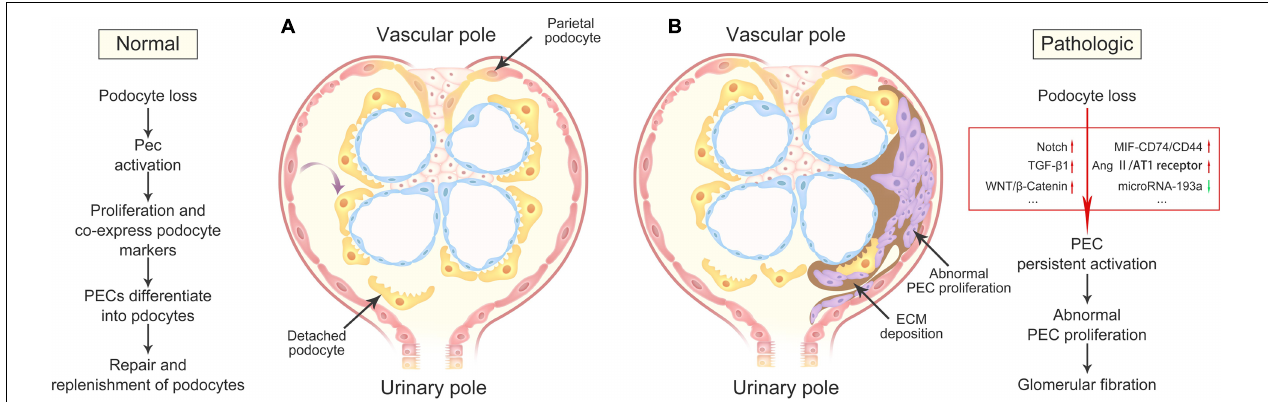
FIGURE 2 | Outcomes of PEC activation in health and disease. (A) Under physiologic conditions, damage or loss of podocytes leads to PEC activation, resulting in its progressively proliferation and differentiation into podocytes, and consequently repair and replenishment of differentiated podocytes lost during normal nephron function. (B) Under pathologic conditions, severe podocyte death or detachment contributes to the abnormalities of multiple signaling pathways, including Notch, TGF- β 1, WNT/ β -Catenin, MIF-CD74/CD44, Ang II/AT1 receptor, and microRNA-193a, resulting in the accumulations of abnormal proliferating PEC and ECM in the Bowman’s space, and finally glomerular fibration. PECs, parietal epithelial cells; ECM, extracellular